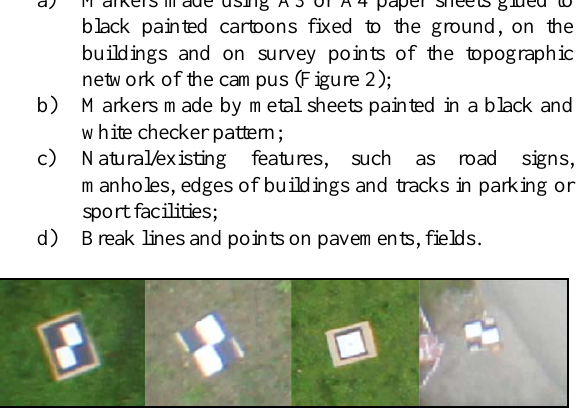
Figure 2 - Types of marker for Ground Control and Check